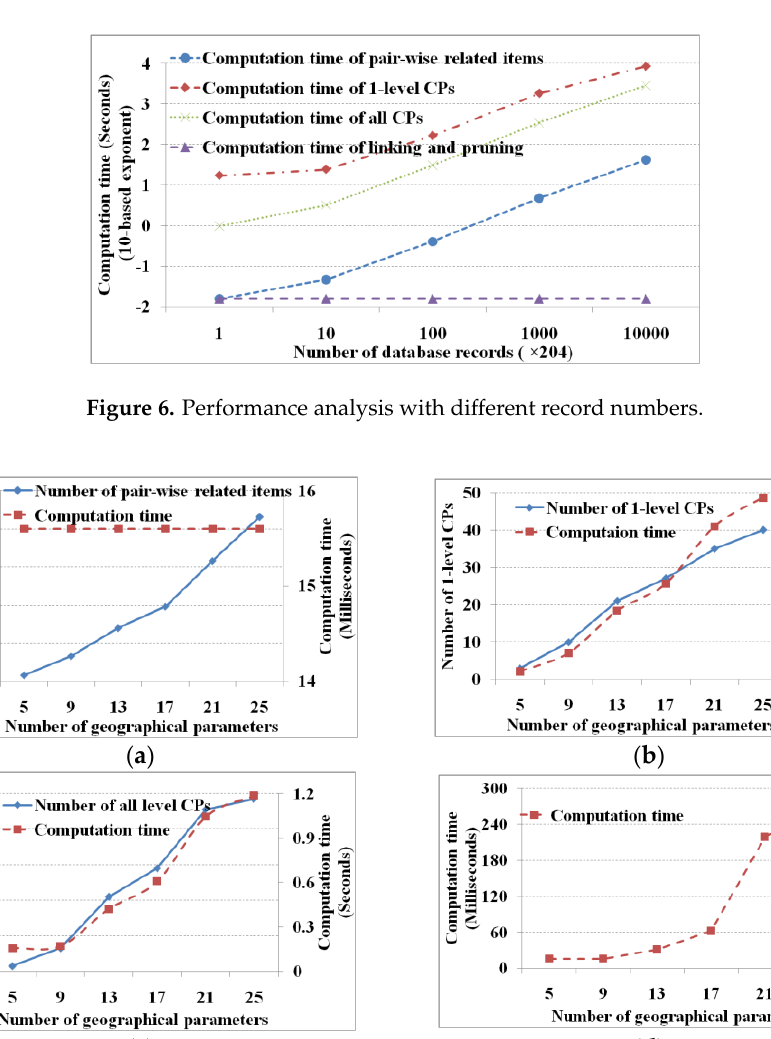
( d ) Figure 5. Performance under different cascading index thresholds. ( a ) Number of one-level cascading patterns and computation time; ( b ) Computation time of linking and pruning; ( c ) Total number of cascading patterns and computation time; ( d ) Partial enlargement of ( c ). From Figures 4 and 5, we know that the lower the evaluation thresholds, the greater are the number of cascading patterns, and vice versa, and the computation time of finding all cascading patterns decreases with increasing thresholds. However, the computation time to find one-level cascading patterns is fixed (i.e., 15.6 s) whether the thresholds are high or low. Given a mutual information threshold, we will get a fixed number of pair-wise related items and database scanningtimes; hence, the computation time of finding the one-level cascading patterns is fixed. As for the computation time of the linking and pruning function, theoretically it is expected to decrease along with increasing evaluation thresholds. However, when the evaluation thresholds reach a specific value (support and cascading index thresholds of 7.5% and 70%, respectively) the computation time does not change. When the threshold reaches the specific value, the linking and pruning times are too small to show changes in computation time. That is to say, when the threshold reaches the specified value, the computation time is shown as a computational unit (i.e., 15.6 ms on our test computer). 4.2.3. Database Size